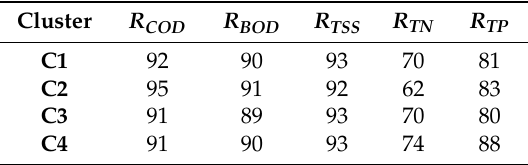
Table 3. The removal rates for each cluster related to organic and inorganic matter (chemical oxygen demand, COD; biological oxygen demand, BOD, and total suspended solids, TSS) and nutrient removal (total nitrogen, TN; total phosphorus, TP) expressed as the percentage of reduction in the incoming pollution concentration when compared with that in the effluent. Cluster R COD R